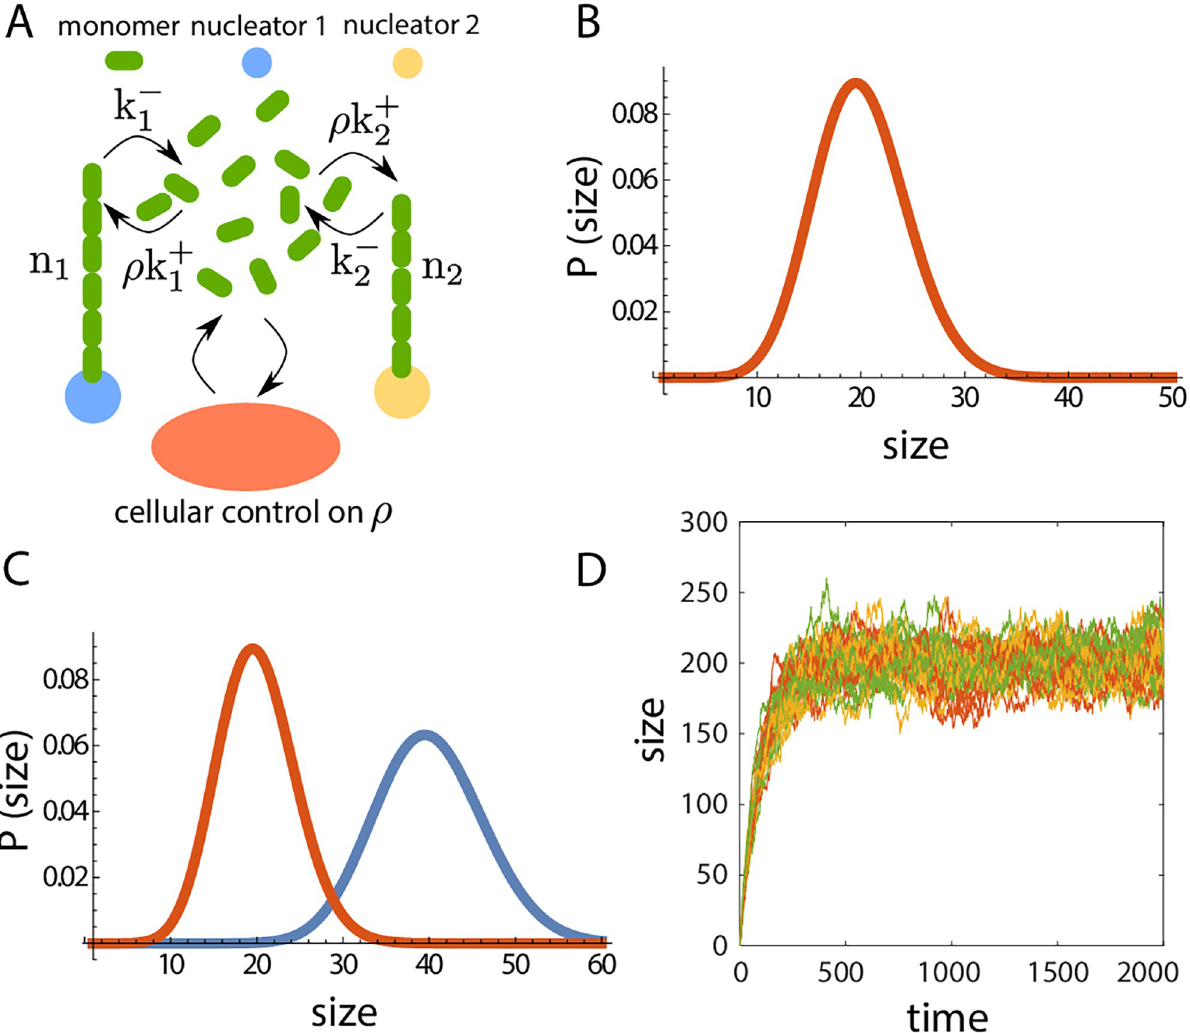
Fig 7. Growth of structures with constant subunit concentration. (A) Schematic representation of the growth of two structures, where the cell maintains a fixed cytoplasmic density of subunits. (B-C) Size-dependent negative feedback enables robust size control of two structures with (C) or without (B) inherent difference in bare growth rates. The steady-state size distributions for the two structures in (B) and (C), computed analytically by solving the master equation. (D) The constant subunit concentration model does not lead to any scaling between the structure size and the system size, when multiple structures growing from a shared subunit pool. The plot shows time series for the size of 10 (green), 20 (yellow) and 40 (red) structures grown from a pool of concentration ρ = 2, with κ = 100.